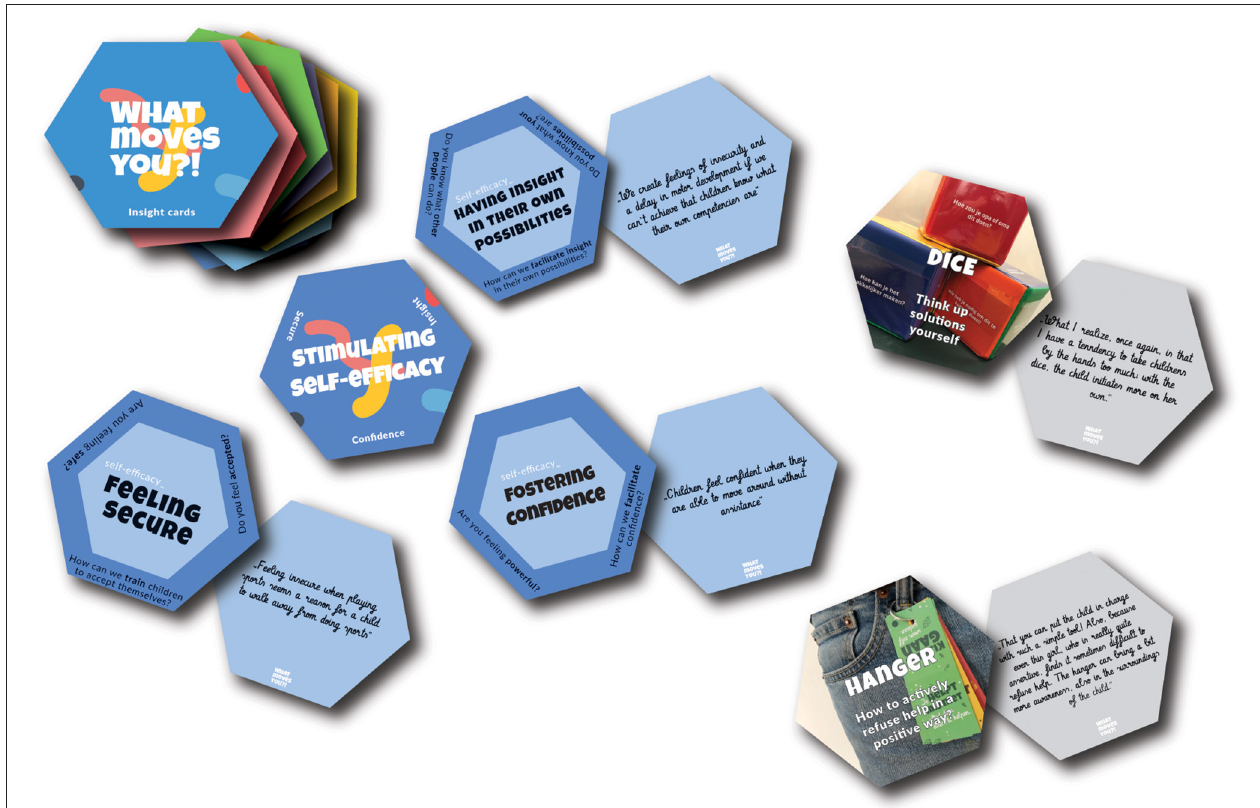
FIGURE 3 | Example of knowledge cards with the theme stimulating self-efficacy